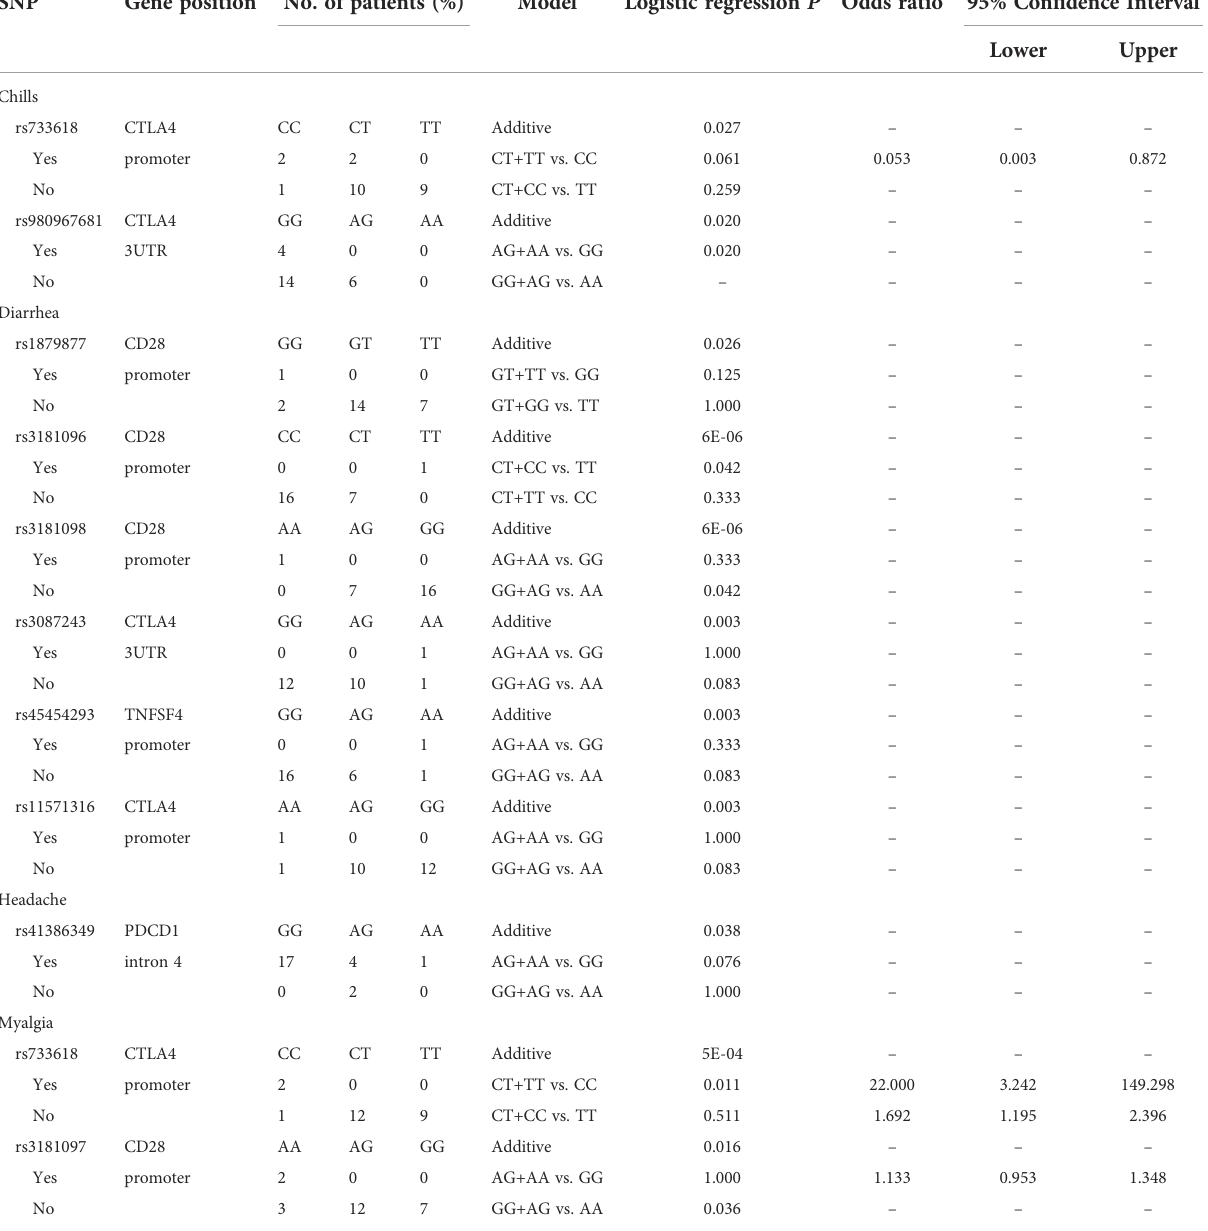
TABLE 6 Side effects with the second dose of adenoviral vector vaccine